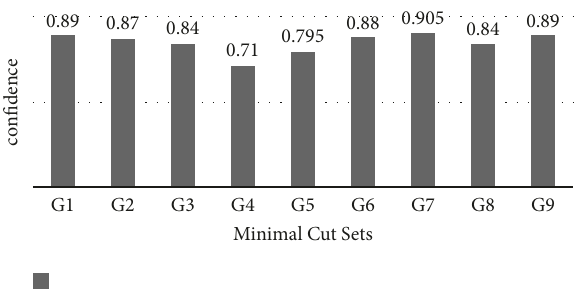
Figure 7: Fault occurrence probability of the minimum cut set.